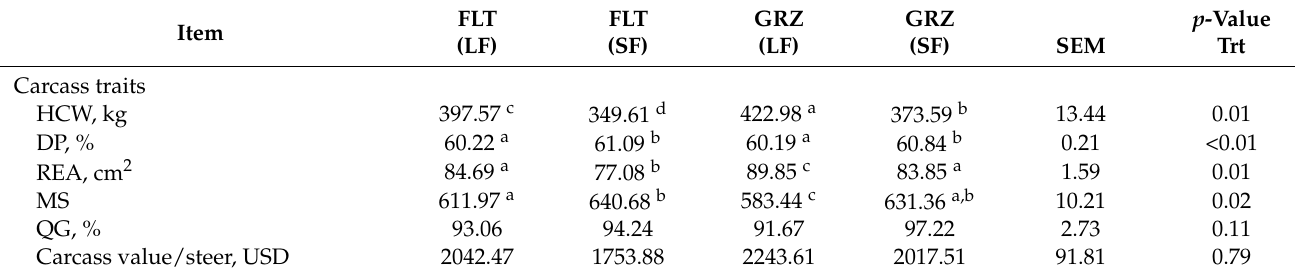
Table 7. Effect of beef steer frame score and extended grazing on carcass trait measurements and value 1